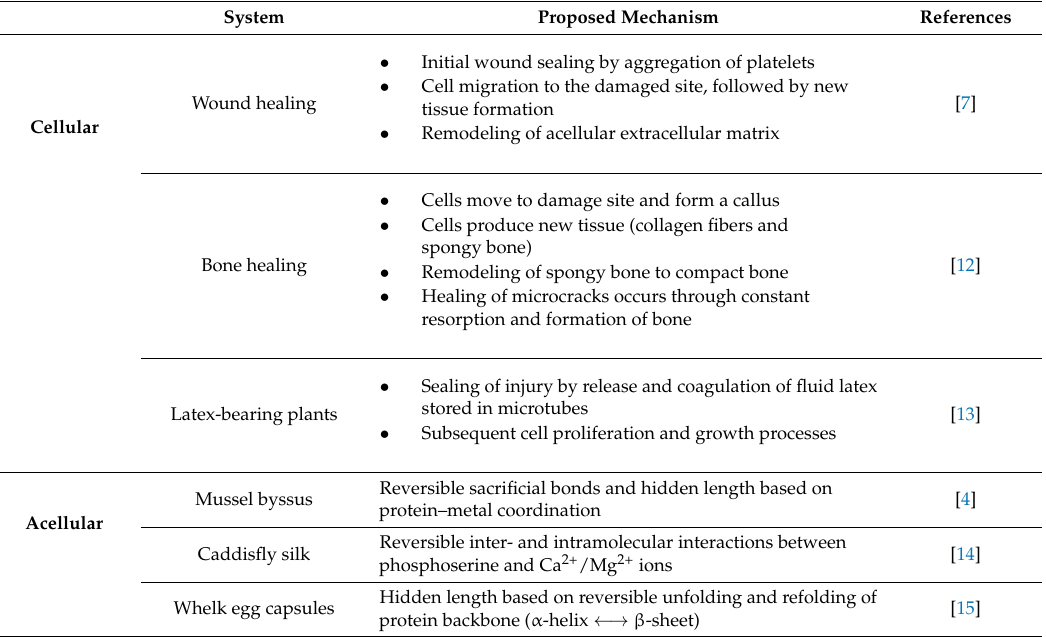
Table 1. Summary of self-healing phenomena found in natural